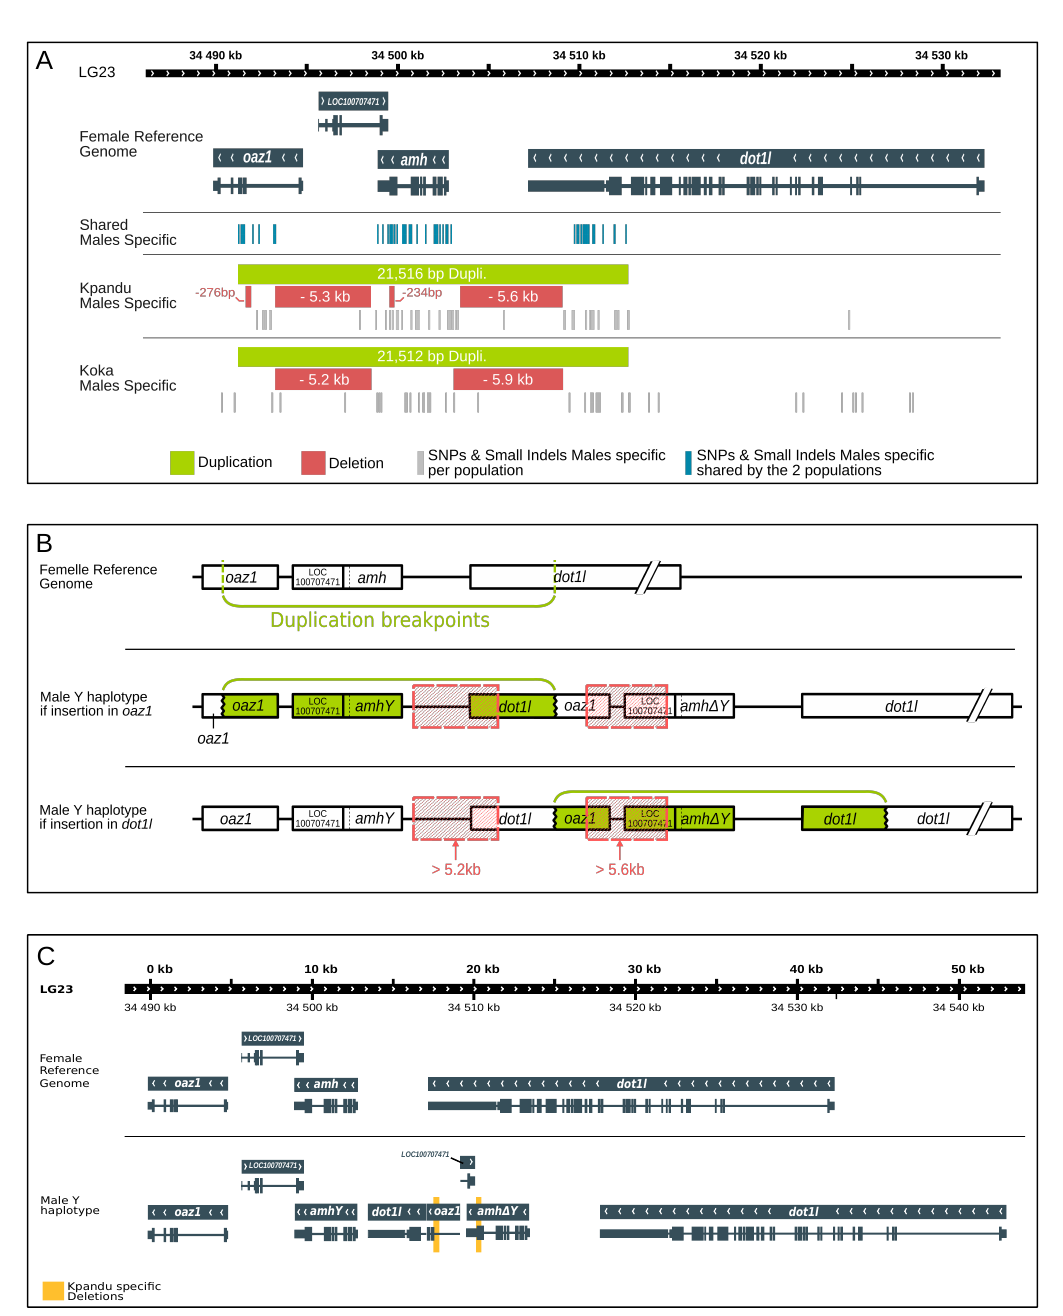
Figure 6. Schematic representation of the duplicated region of LG23 and its structural variants and polymorphic sites found with DELLY and FreeBayes. The tandem duplication includes the amh gene and part of the oaz1 and dot1l genes. The duplicated regions in each population (in green) are shown with the corresponding deletions and suggested size (in red). The shared male SNPs are shown in blue bars while the population male-specific SNPs are shown in light grey bars. ( A ) Schematic view of mapping results of the Y chromosome by WGS of the Kpandu and Koka males against the female XX reference genome. ( B ) Schematic representation of the two possible places of insertion of the tandem duplication in oaz1 and dot1l genes. Both large deletions found with DELLY are likely to be placed in the oaz1-dot1l chimera as the genes are already truncated on the Y haplotype. ( C ) Schematic representation of the inferred Y haplotype of Kpandu and Koka